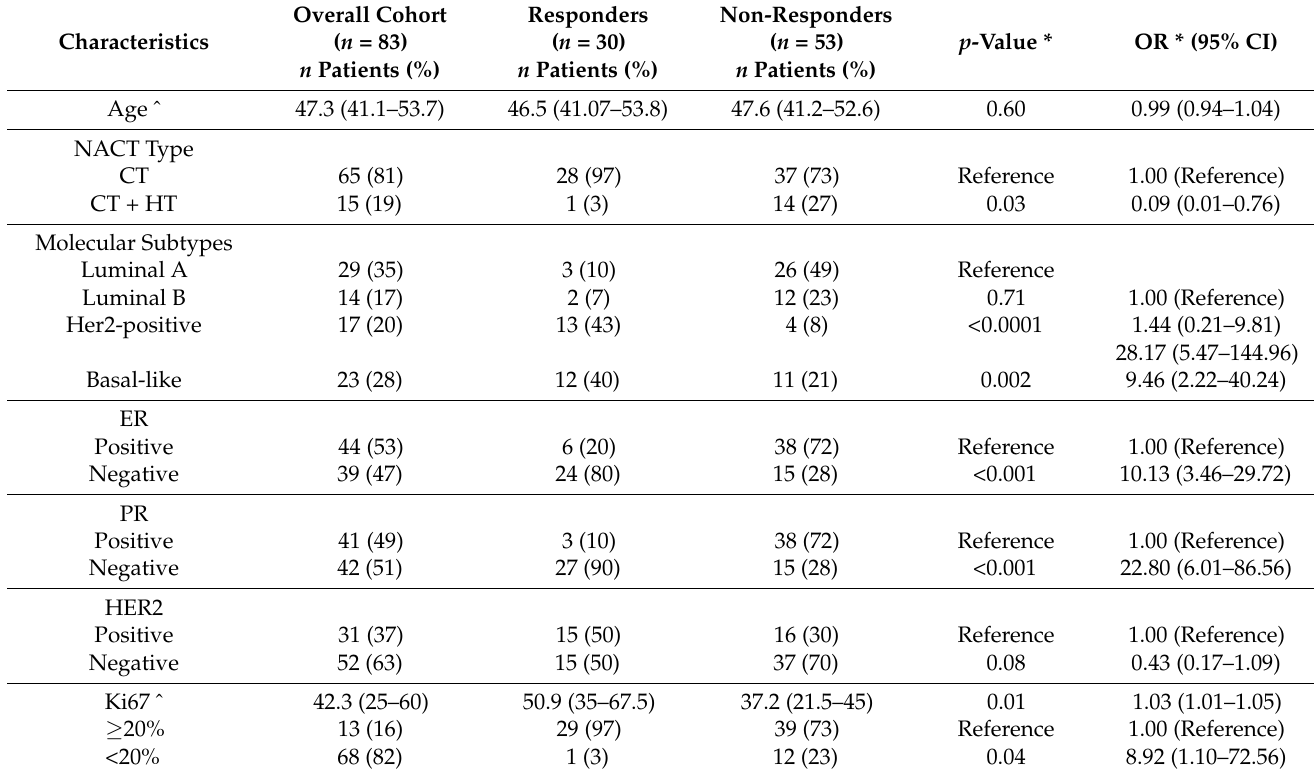
Table 1. Baseline characteristics of the study population and association analysis with response to therapy.